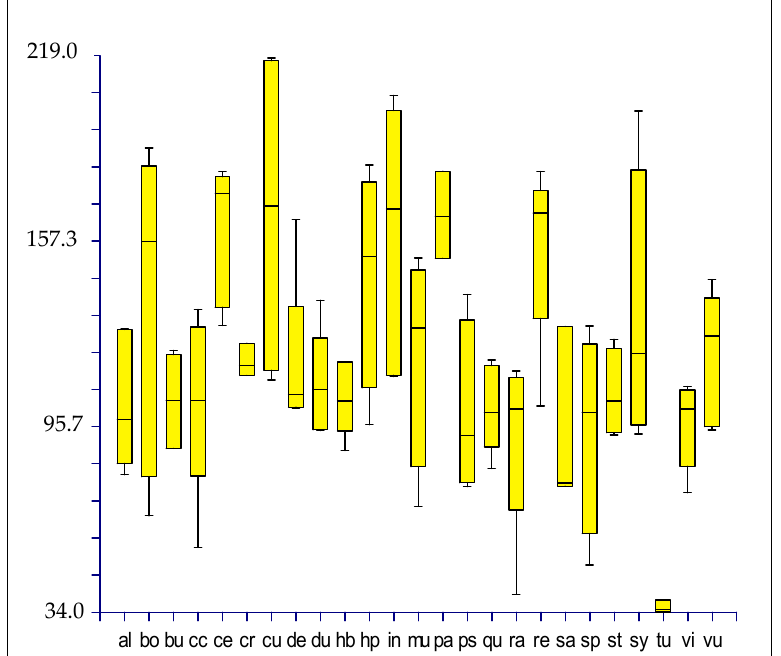
Figure 10. Box plots illustrating the variability of the length of the flat border of the seed ( y -axis; measurements are in µm) per taxon ( x -axis; abbreviation follow Table 1).